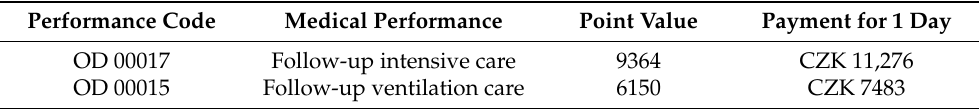
Table 4. Payments for treatment days of long-term nursing care including the value of overheads for